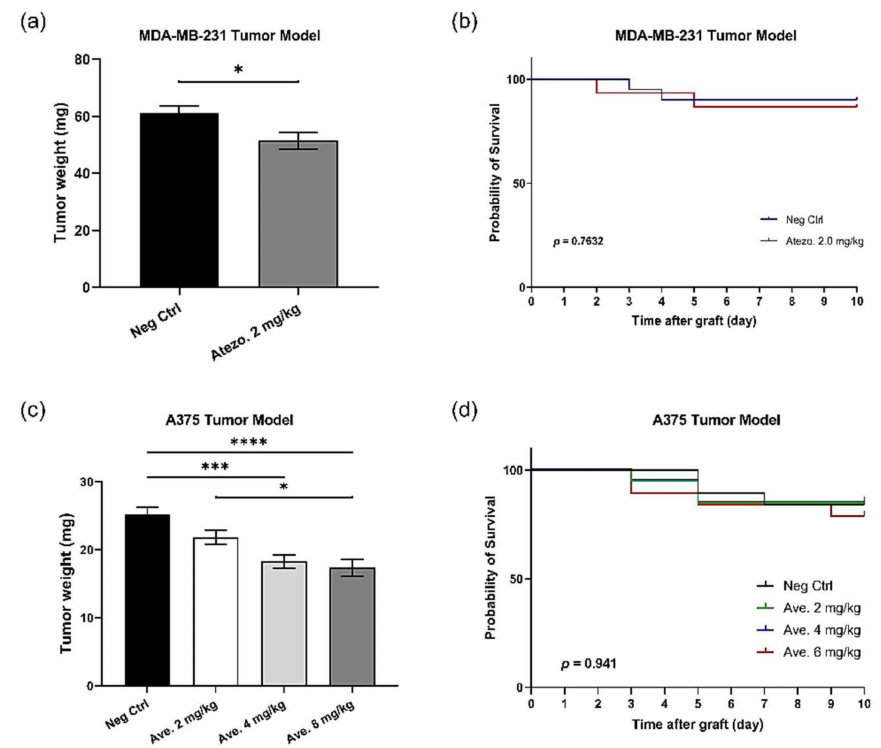
Figure 10. In ovo PD-L1 inhibitors’ treatment in the MDA-MB-231 tumor model and the A375 tumor model: ( a ) On the MDA-MB-231 tumor model, atezolizumab at 2 mg/kg induced 15.97% of tumor regression ( p = 0.0146, *); ( b ) In the MDA-MB-231 tumor model, no evident toxicity was induced by atezolizumab treatment; ( c ) Iin the A375 tumor model, avelumab led to 13.41% tumor regression at 2 mg/kg ( p = 0.1217), 27.4% tumor regression at 4 mg/kg ( p = 0.001, ***), and 31.0% tumor regression at 8 mg/kg ( p < 0.0001, ****). The statistical difference between 2 and 8 mg/kg was p = 0.026 (*), ( d ) In the A375 tumor model, no evident toxicity was induced by avelumab